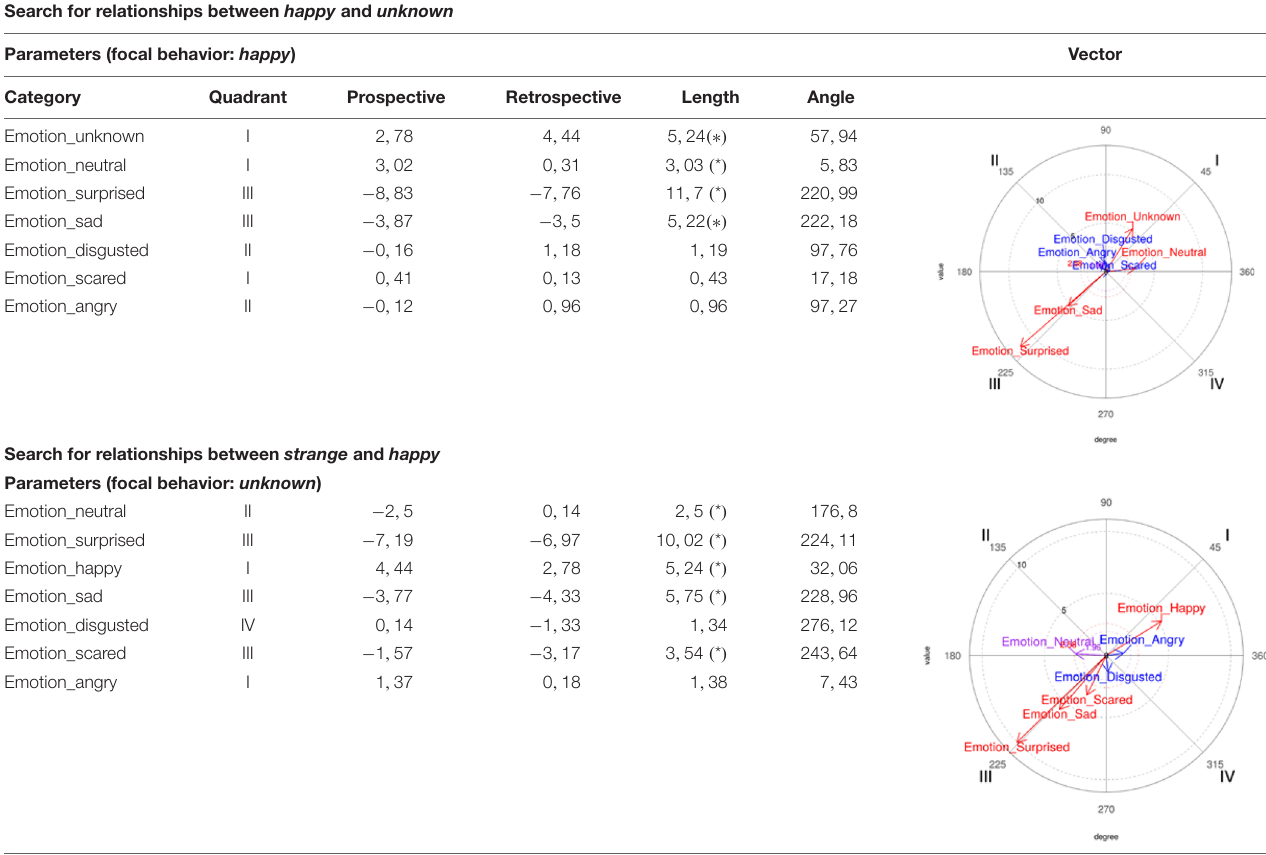
TABLE 4 | Polar coordinate analysis centered on happy/unknown and unknown/happy, corresponding to the boys’ records. Search for relationships between happy and unknown Parameters (focal behavior: happy